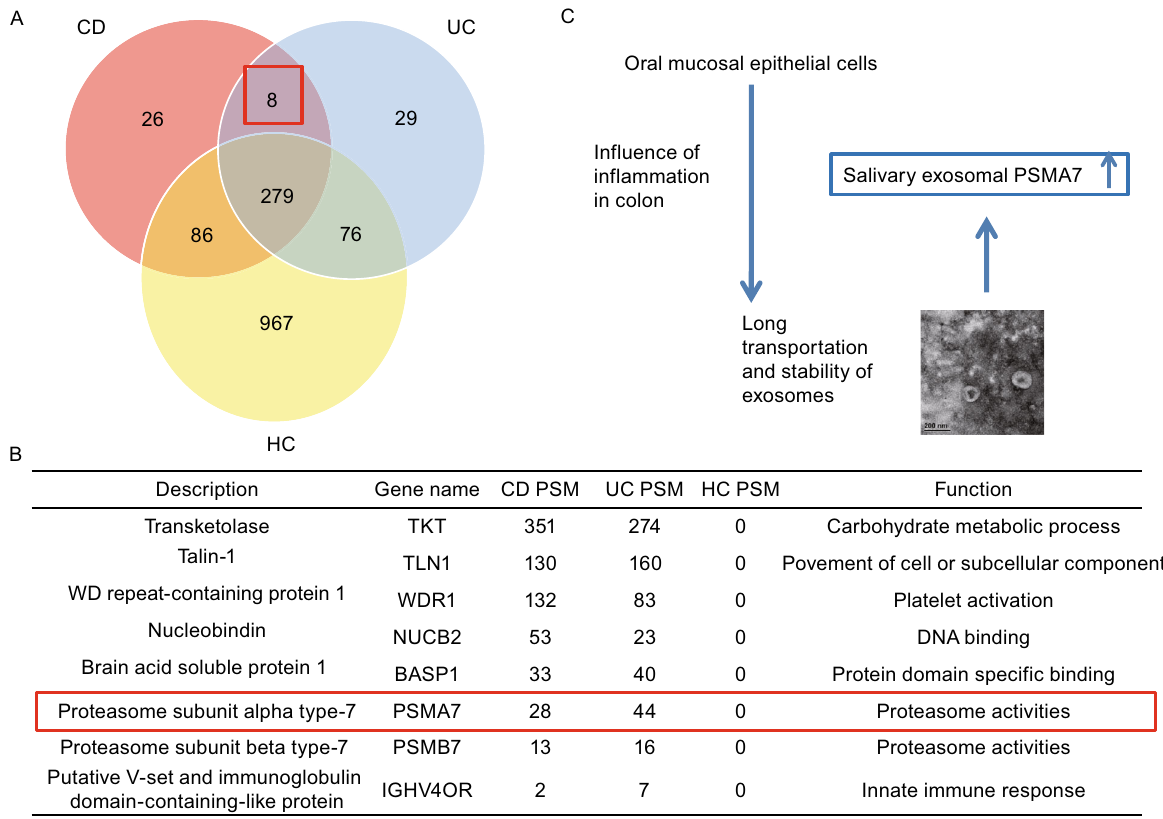
Figure 2. Proteins in salivary exosomes of IBD and healthy groups. (A) Comparison of the numbers of proteins in healthy controls and IBD patients. (B) 8 proteins that only exist in IBD patients (both CD and CD). The most reasonable protein that may interact between oral cavity and colon intestine is PSMA7. (C) PSMA7 ’ s function in the in fl ammation or cancer in the digestive systems had been reported by many studies. The speculated way shows the expression of PSMA7 is high in the salivary exosomes of IBD patients. IBD may in fl uence the oral mucosal cells to secret exosomes, which may express the similar protein pattern of colon